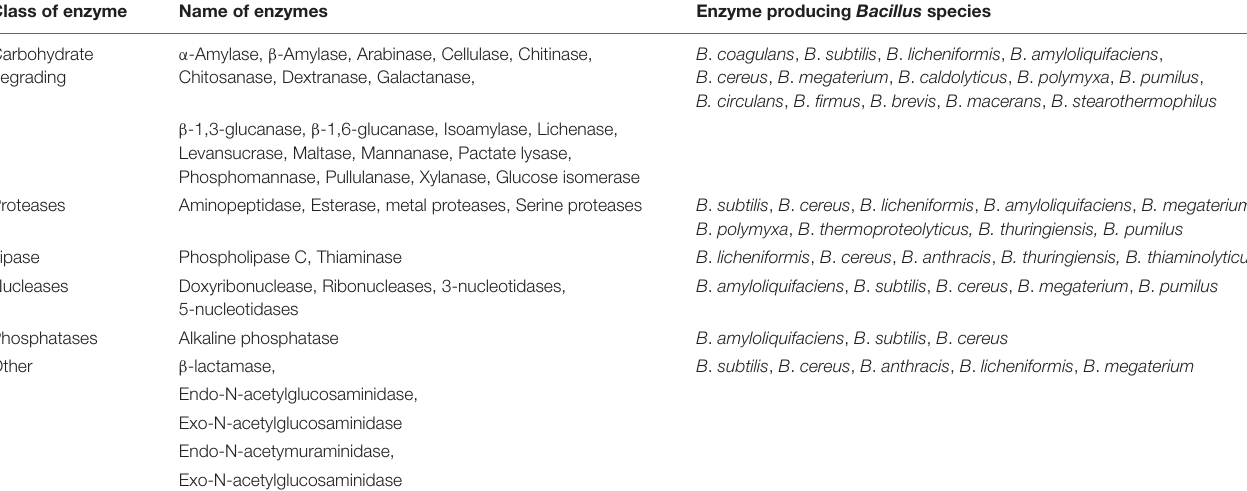
TABLE 2 | List of Bacillus species used for production of enzymes. Class of